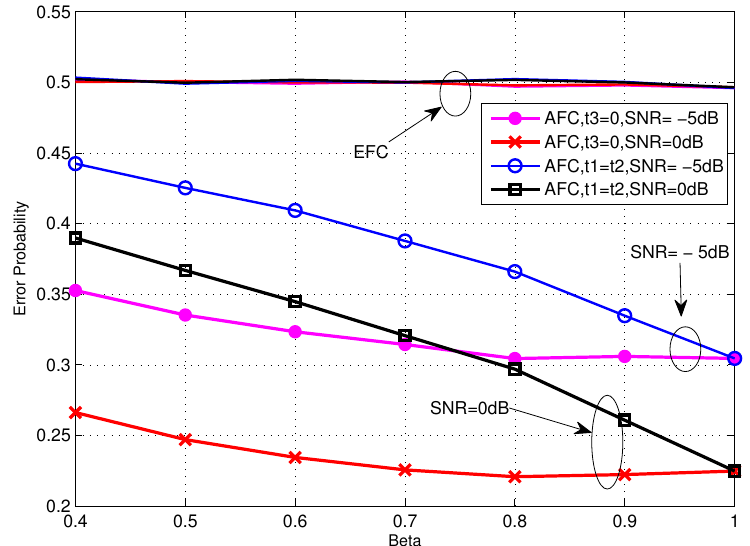
Figure 5. Error probabilities at the AFC and EFC as functions of various β for snr L = 5 dB over low SNR